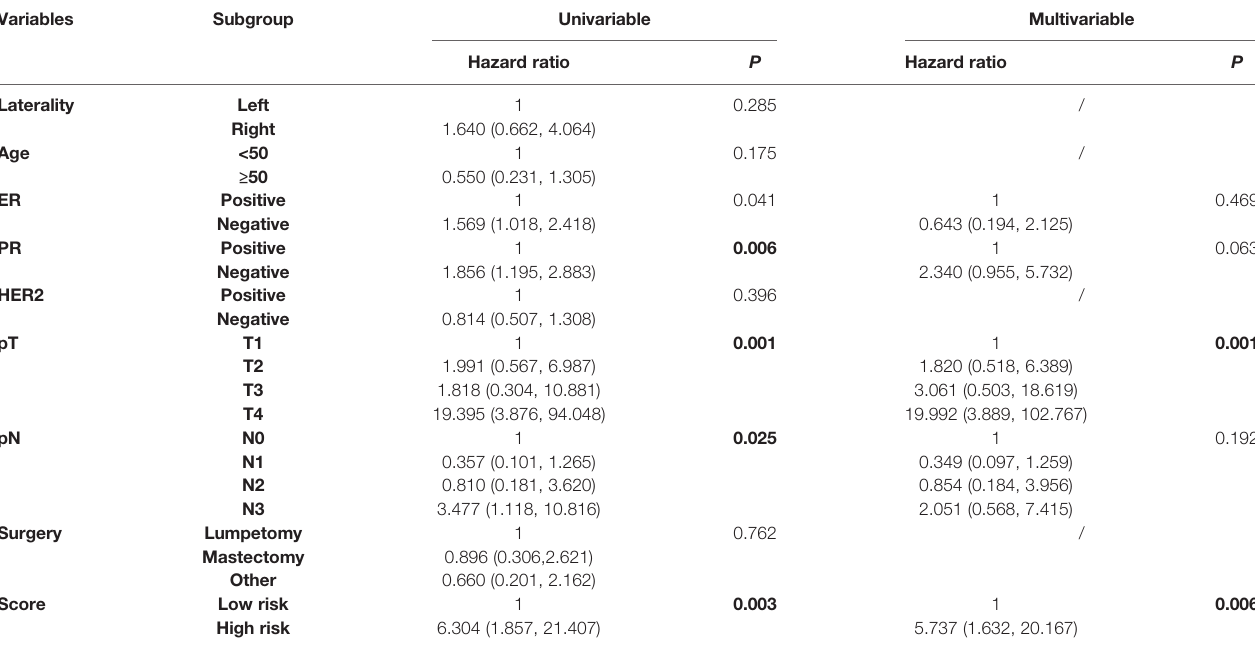
ER,Estrogenreceptor;PR,Progesteronereceptor;HER-2,Humanepidermalgrowthfactorreceptor-2;pT,pathologicallydiagnosedtumorsize;pN,pathologicallydiagnosedlymphnode status. Bold values indicate statistical signi fi cance